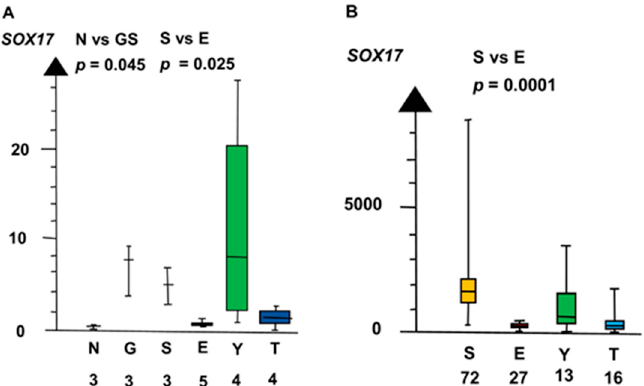
Figure 3. RNA expression of SOX17 in the two microarrays ( A , B ) show that germ cell neoplasia in situ (G), seminoma (S), and yolk sac tumor (Y) had a high RNA expression and that embryonal carcinoma (E) and teratoma (T) had a low RNA expression.